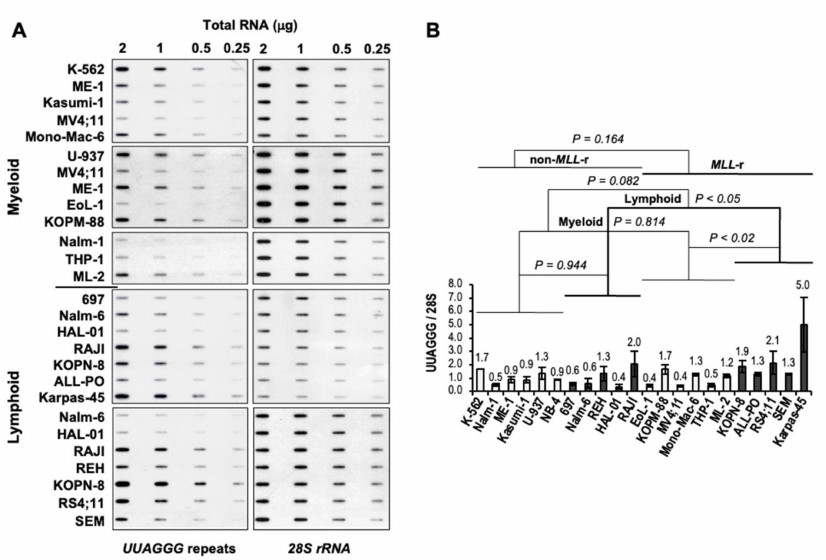
Figure 2. Increased levels of UUAGGG repeat-containing RNA in MLL-r ALL. ( A ) Representative TERRA slot-blot analysis of total RNA extracted from leukemia cell lines. DNase -treated total RNA was loaded at 2.0, 1.0, 0.5, and 0.25 µ g per slot on a filter and UV cross-linked. Filters were sequentially hybridized with 32 P-end-labeled oligonucleotides specific for TERRA [5 (cid:48) -(CCCTAA) 4 -3 (cid:48) ], and 28S rRNA (5 (cid:48) -GGGAACGTGAGCTGGGTTTAGACC-3 (cid:48) ) as a transcriptome loading control. We quantified autoradiography signals by ImageJ densitometry analysis. ( B ) Quantitation of UUAGGG repeat-containing RNA levels in myeloid (light columns) and lymphoblastic (dark columns) leukemia cell lines carrying (or not) MLL rearrangements. For each cell line, UUAGGG repeats signals from different blots were normalized to the corresponding 28S rRNA signals for equal transcriptome loading (UUAGGG/28S), averaged, and expressed relative to the mean value of UUAGGG/28S levels in non- MLL -r leukemia cell lines. Error bars represent the standard error of the mean (s.e.m.) between two and five separate experiments. We calculated the p -value through a two-way ANOVA